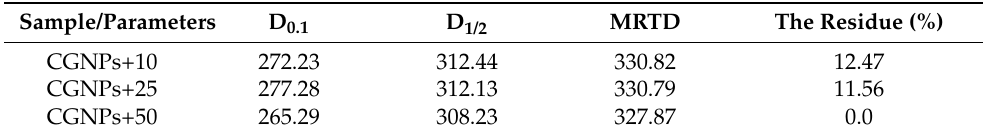
Table 2. Parameters of the CGNPs third stage degradation with different concentrations of α - tocopherol. D 0.1 : initial decomposition temperature; D 1/2 : temperature values for the 50 wt.%; MRTD: the temperature for the maximum rate of decomposition; Residue: residue obtained at 600 ◦ C. Sample/Parameters D 0.1 D 1/2 MRTD The Residue (%) CGNPs+10 272.23 312.44 330.82 12.47 CGNPs+25 277.28 312.13 CGNPs+50